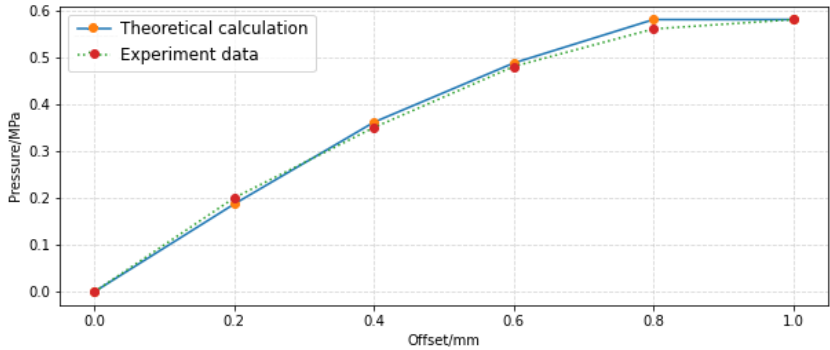
Figure 17. Comparison between theoretical pressure model and experiment.